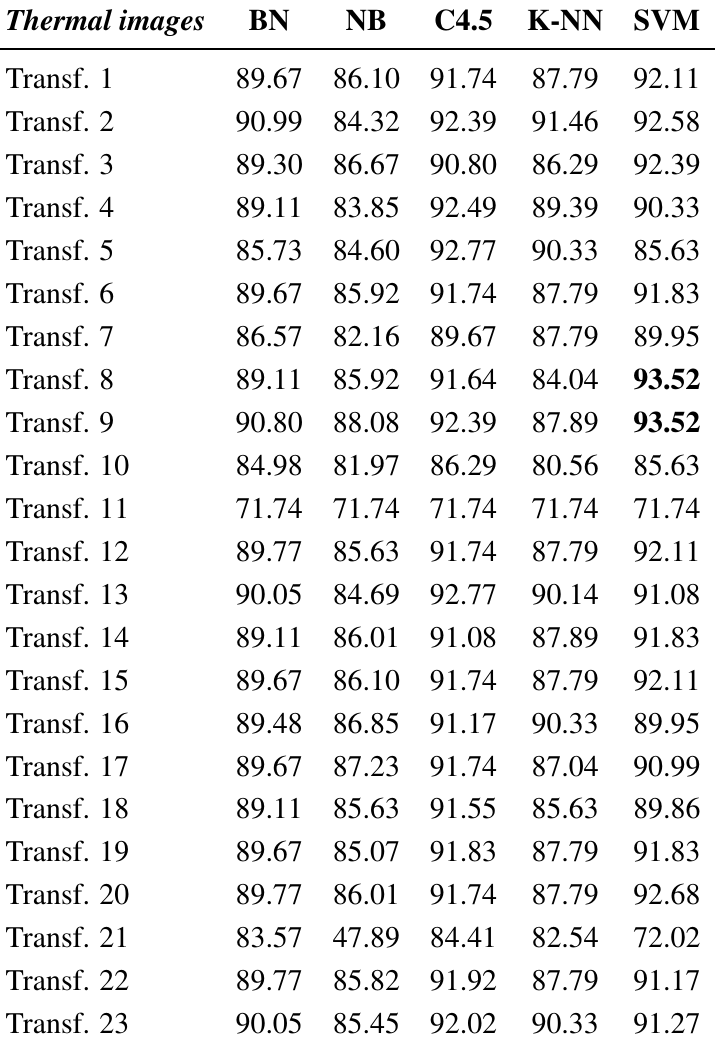
Table 5. IK4-TEKNIKER thermal images: 10-fold cross-validation accuracy percentage obtained for each classifier using each of the proposed